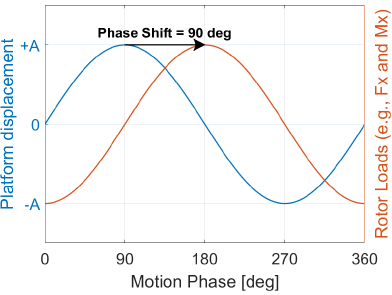
Figure 12. Expected relationship between rotor loads and platform